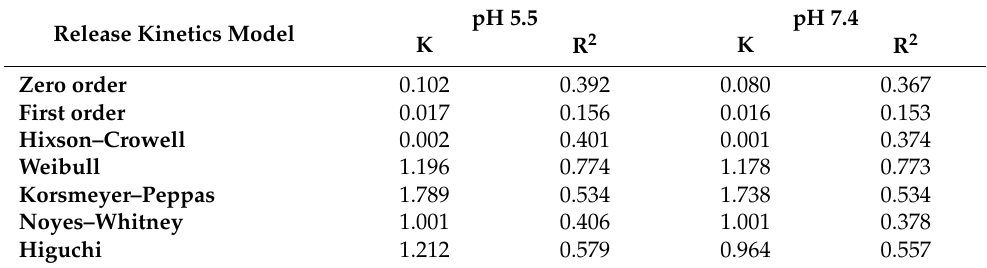
Table 4. Kinetics data of Cf release from PLGA NPs in different pH mediums (pH 5.5 and pH 7.4).